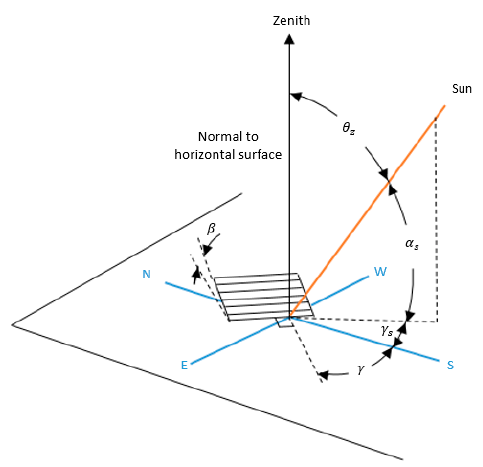
Figure 8. Incident ( θ ), zenith ( θ _z), tilt ( β ) and azimuth ( γ ) angles.